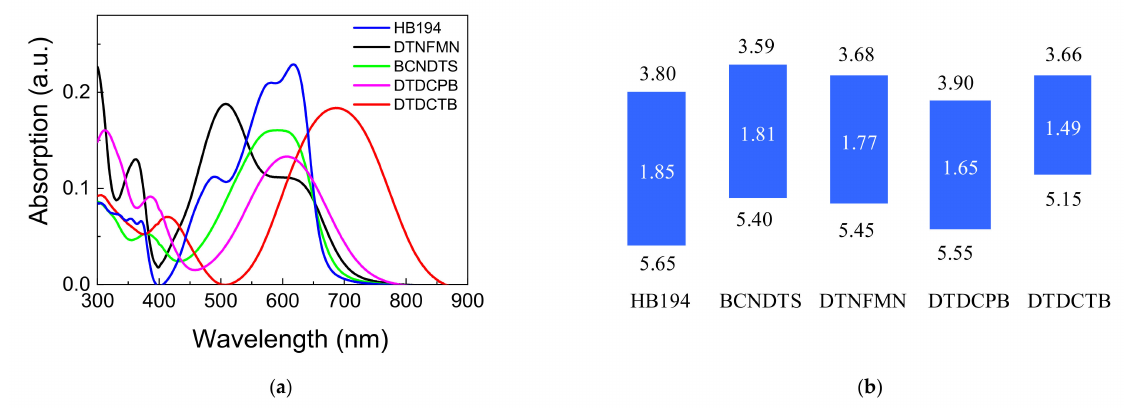
Figure 2. ( a ) UV-vis absorption spectra of the vacuum-deposited films of each molecule, ( b ) HOMO and LUMO energy levels and energy gap in eV.